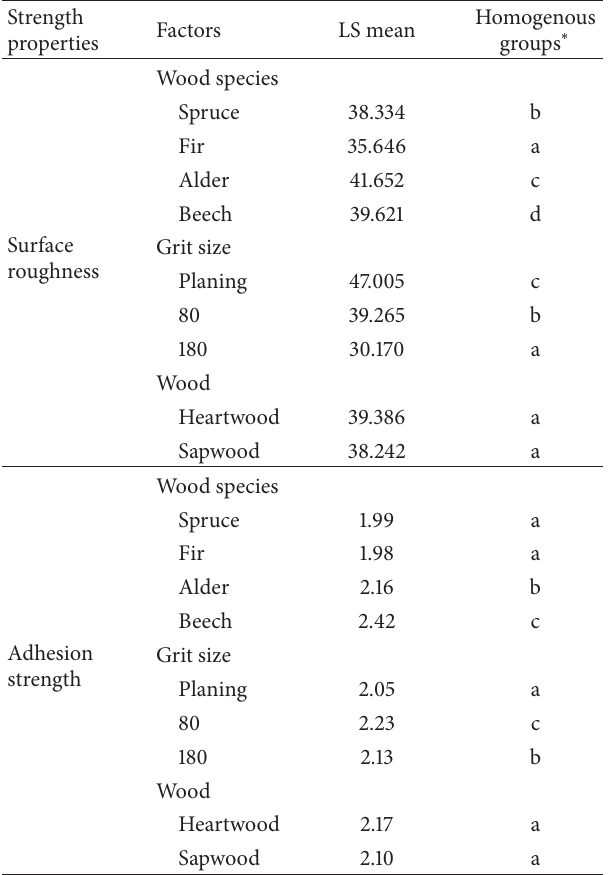
Table 3: Duncan test results of the samples.